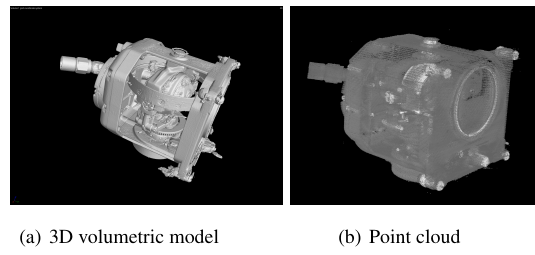
Figure 7. Primitives fitting on photogrammetry model